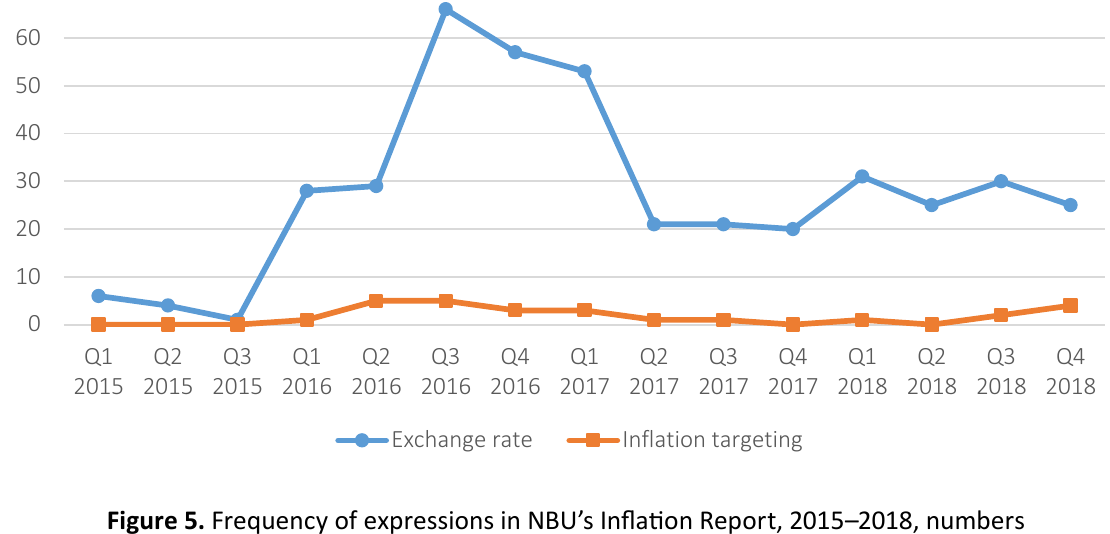
Figure 5. Frequency of expressions in NBU’s Inflation Report, 2015–2018,